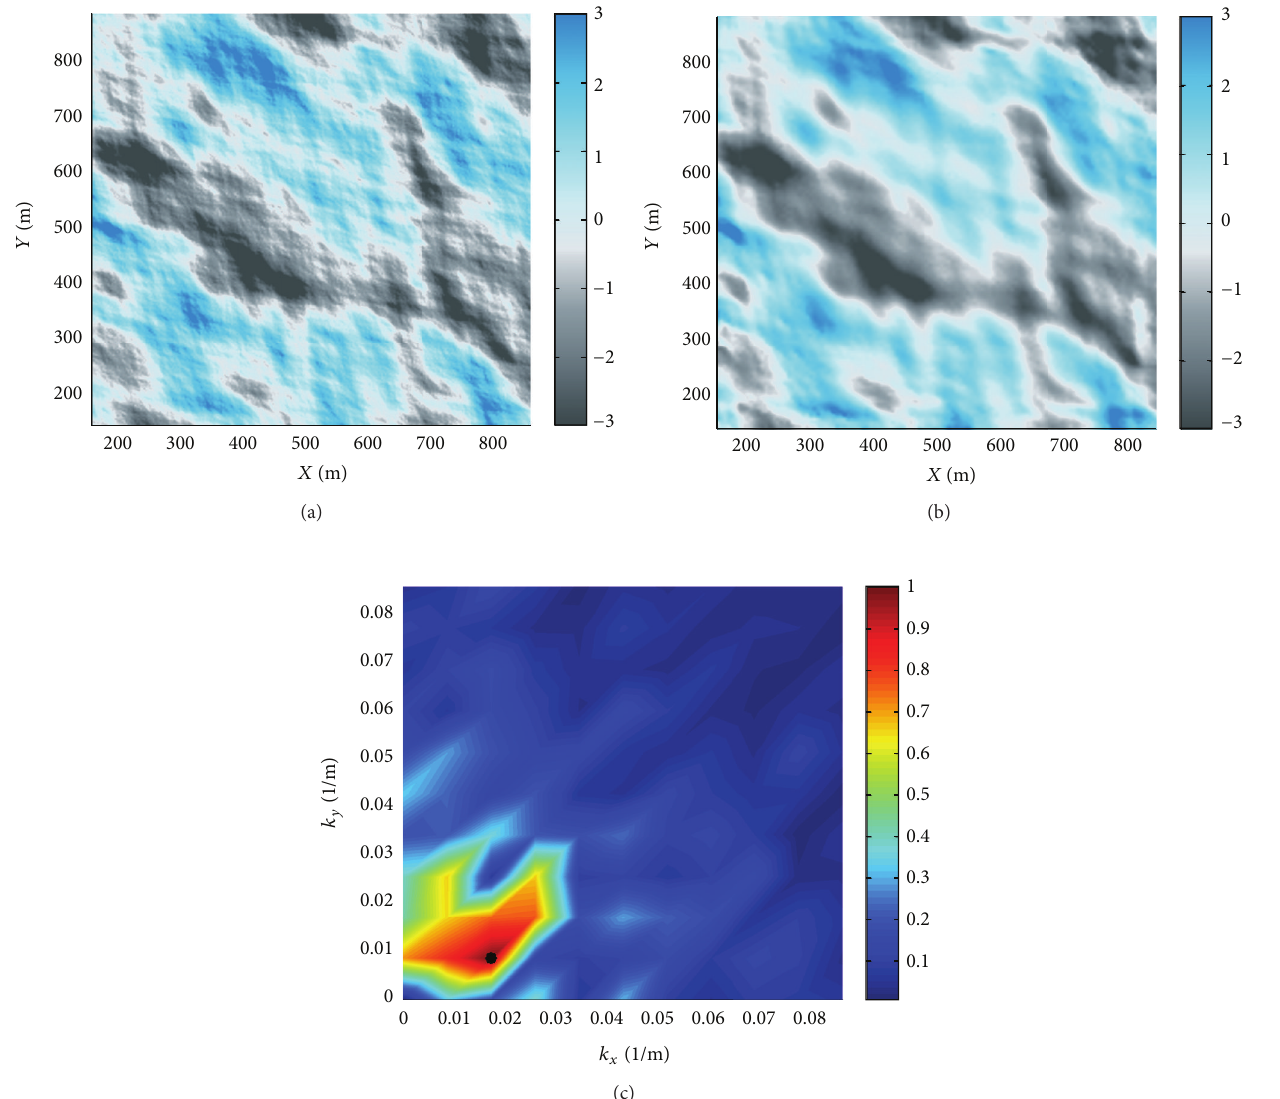
Figure 3: (a) Surface plot of the selected part of the modeled sea surface from Figure 1(a) that is to be imaged, (b) the imaged sea surface, and (c) the spectral plot of the imaged sea surface shown in (b). The indicated peak of the spectrum corresponds to these spatial wavenumber values: 𝐾 𝑥 = 0.01704 and 𝐾 𝑦 = 0.00852 . The imaging technique was applied in